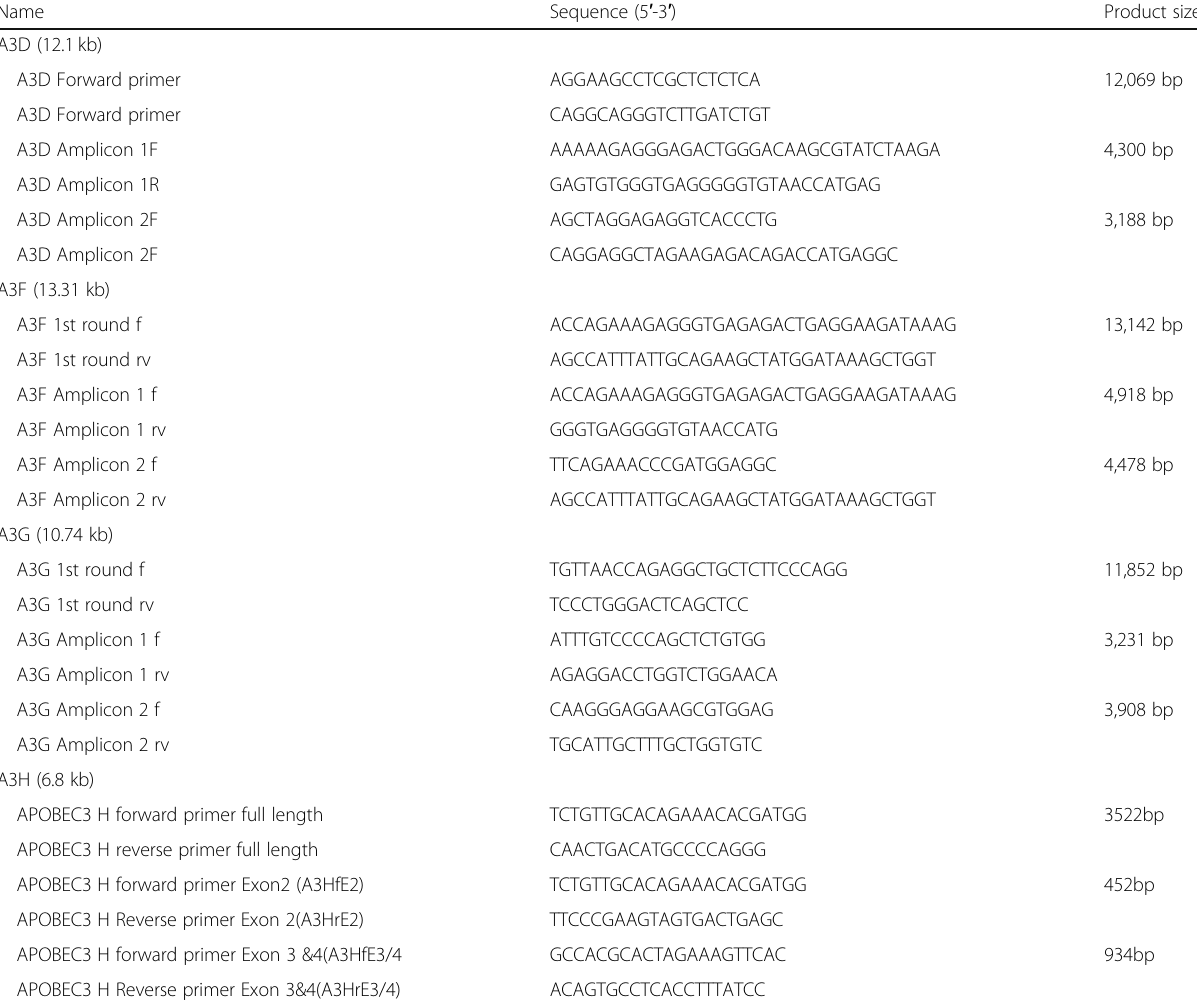
Table 1 List of APOBEC3 primers designed; primer name, sequence and product size are